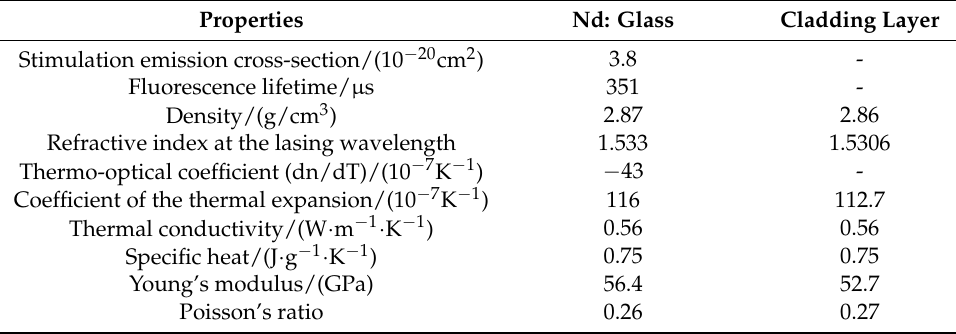
Table 1. Main parameters of Nd: glass and the cladding layer.